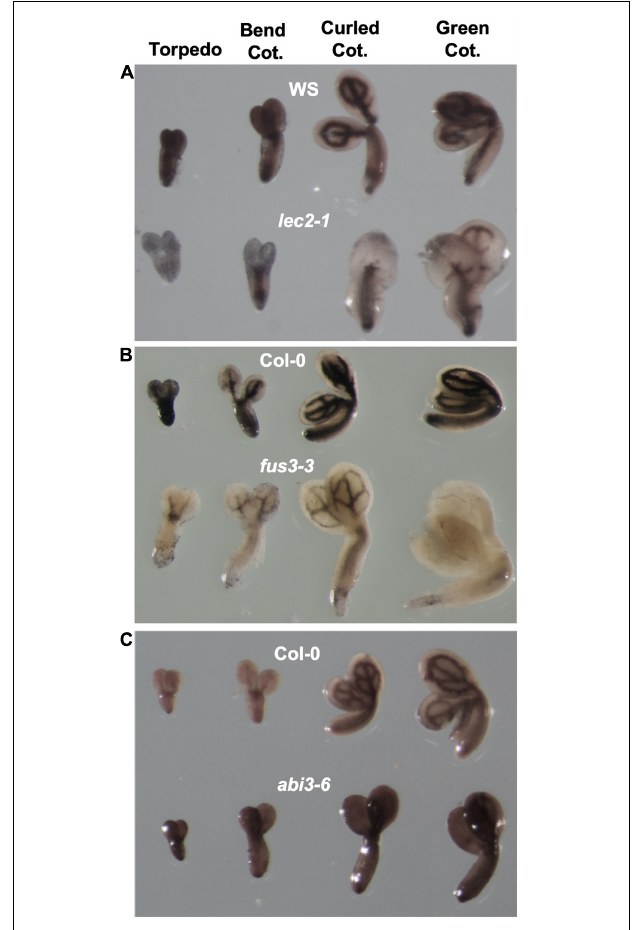
FIGURE 1 | Iron distribution during embryo development in B3 transcription factors mutants. Perls/DAB staining was performed in isolated embryos from torpedo to green cotyledon stages. In each image the upper rows show wild-type embryos and the lower rows represent B3 transcription tractor mutants. (A–C) Show lec2-1 , fus3-3, and abi3-6 , respectively. Cot,